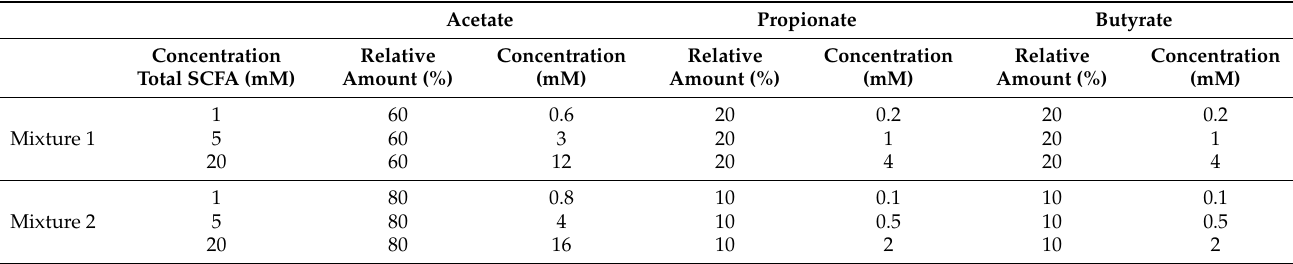
Figure 1. Experimental timeline. Table 1. Composition of mixtures of SCFAs.